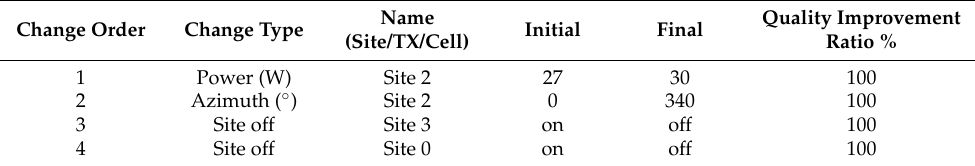
Table 3. Optimal parameters using ACP.